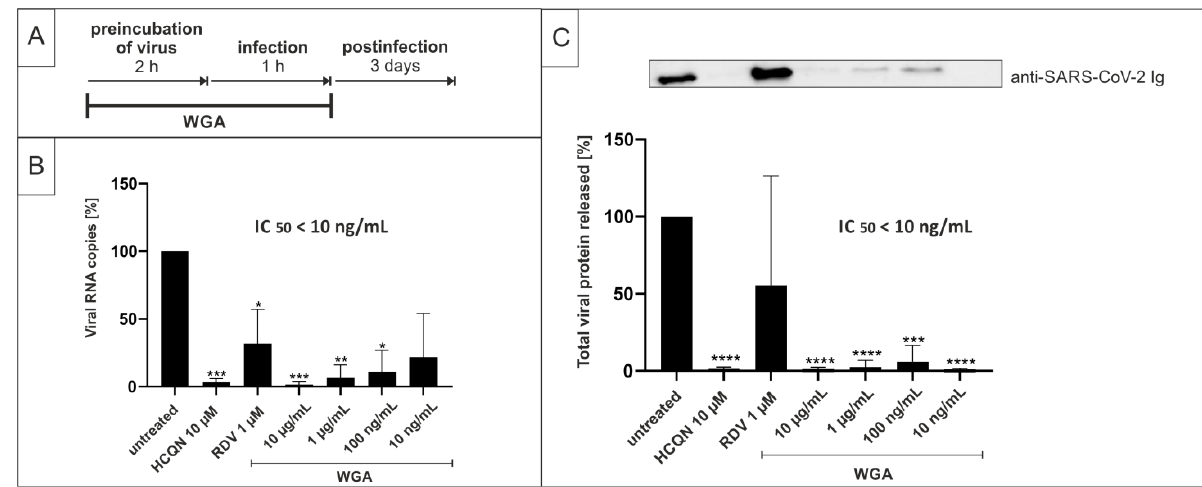
Figure 3. Preincubation of virus stocks with WGA blocks SARS-CoV-2 infection in Vero B4 cells. ( A ) Treatment scheme. TOA of WGA was during preincubation of virus and infection of cells. Virus stock was preincubated with WGA for 2 h and the dilution was then used to infect Vero B4 cells for 1 h. ( B ) qRT-PCR of cell culture supernatant after preincubation of SARS-CoV-2 with WGA for 2 h and no further treatment after infection. HCQN at 10 µ M and RDV at 1 µ M were added as a control. Analysis of three independent experiments. ( C ) Western blot analysis of released virions. Supernatants were harvested 3 dpi, virions were purified and analyzed by Western blot using anti-SARS-CoV-2 nucleoprotein antibody. Densitometric analysis of four independent experiments ± standard deviation using AIDA ® , one representative Western blot is shown. * p ≤ 0.05, ** p < 0.005, *** p < 0.0009 and **** p < 0.0001 using a one-sample t-test .